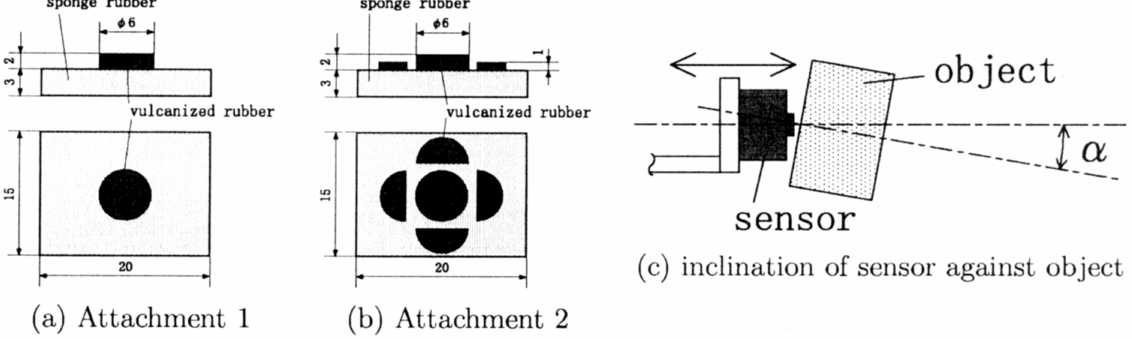
Fig. 10. Geometry of surface attachments and inclination of sensor against object.